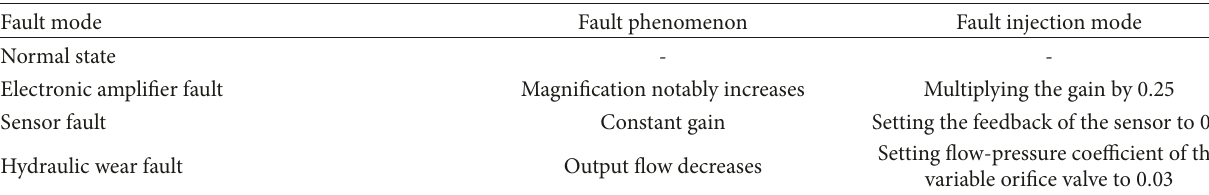
Table 1: Fault injection